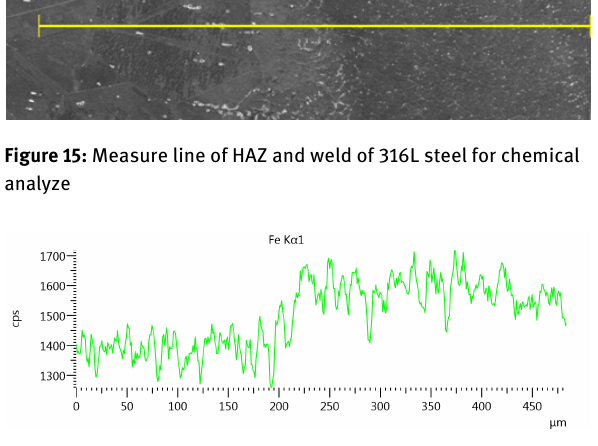
Figure 16: Ferrite amount alongside measurement line